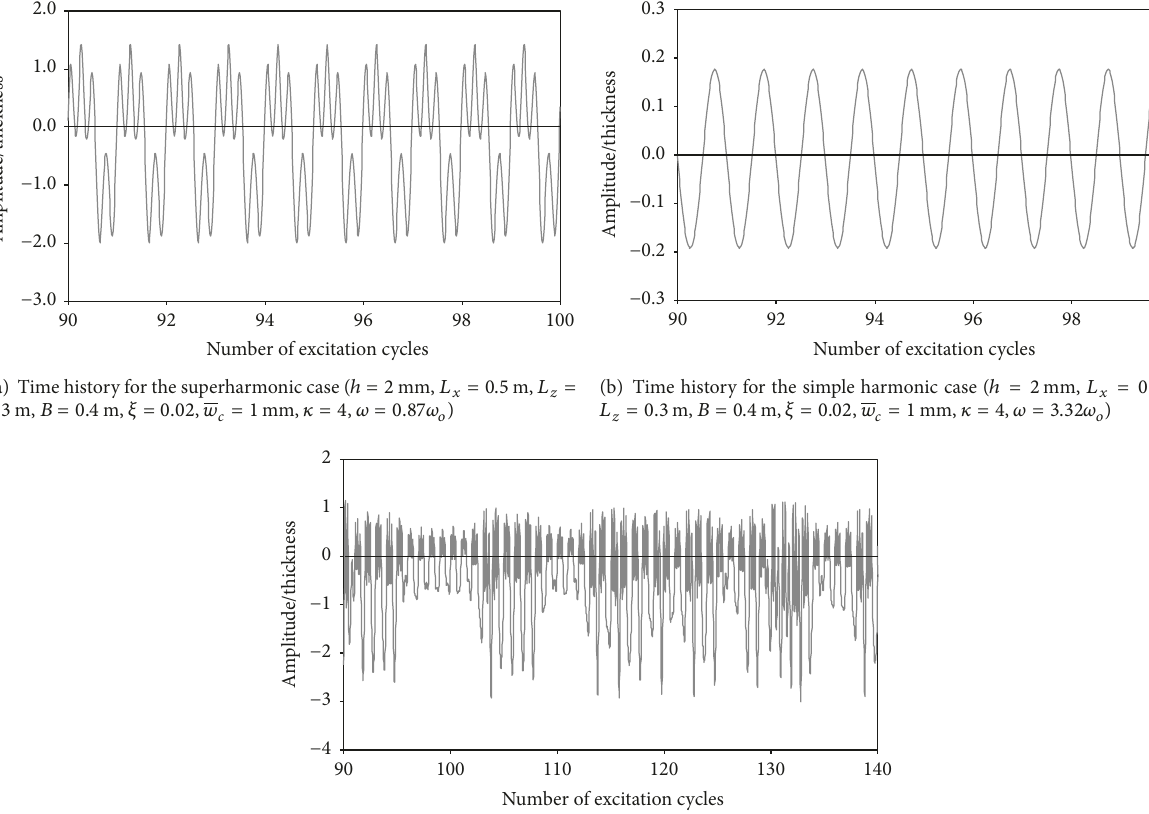
(c) Time history for the chaotic case ( ℎ = 2 mm, 𝐿 𝑥 = 0.5 m, 𝐿 𝑧 = 0.6 m, 𝐵 = 0.4 m, 𝜉 = 0.02 , 𝑤 𝑐 = 2.5 mm, 𝜅 = 4 , 𝜔 = 0.87𝜔 𝑜 )